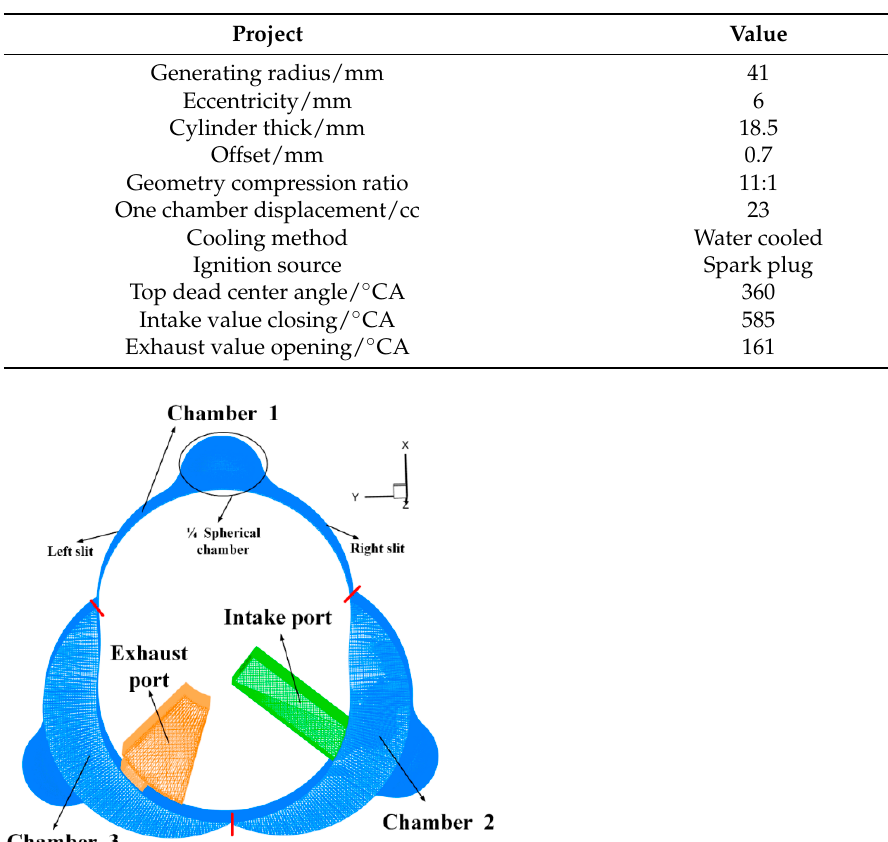
Table 1. Main structural parameters of XMv3 rotary engine [13].